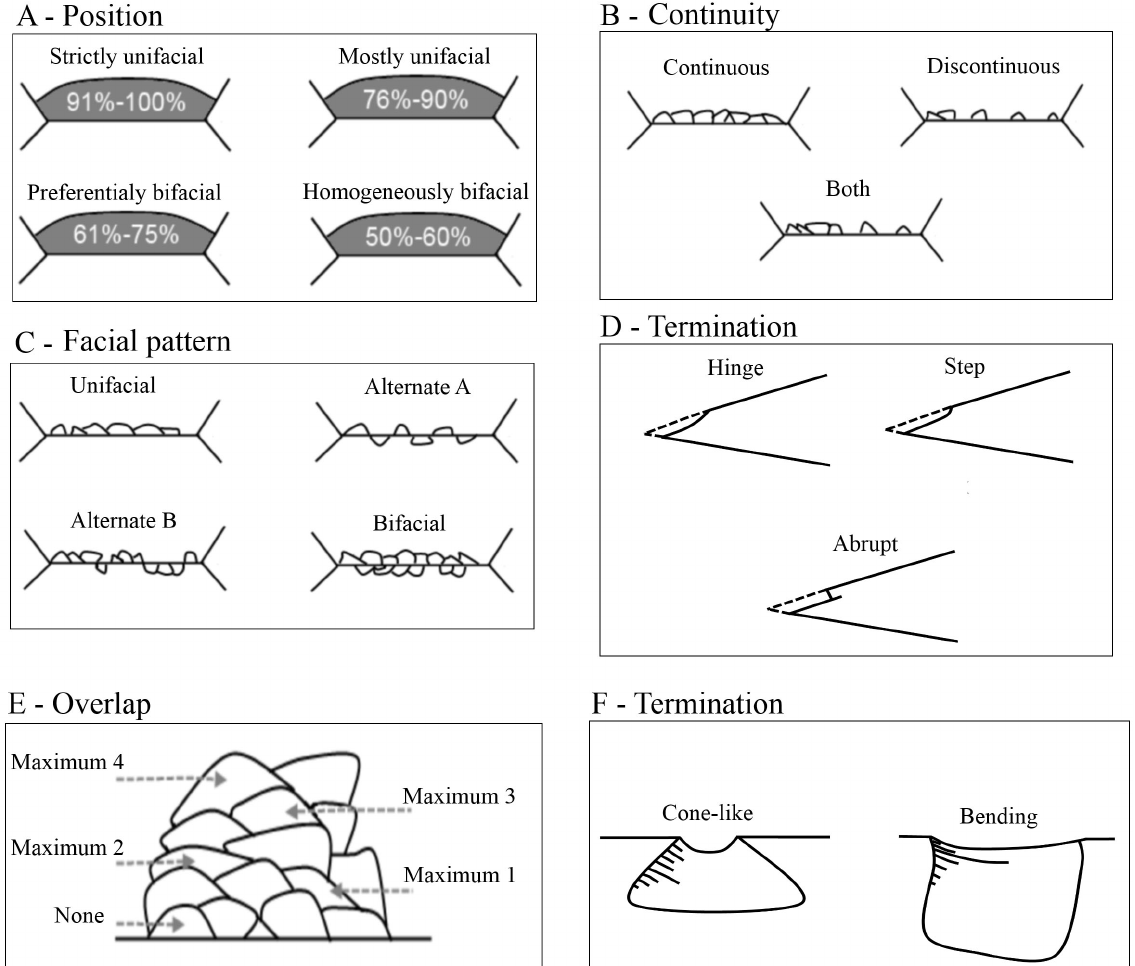
Figure 2. Outline of the criteria used to describe the arrangement and form of the micro-flake